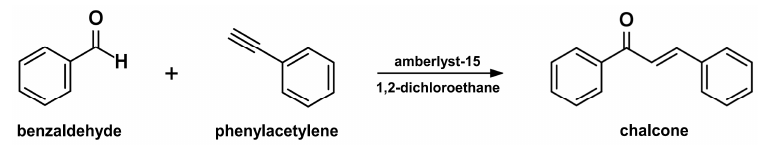
Scheme 8. Solid acid catalyst mediated